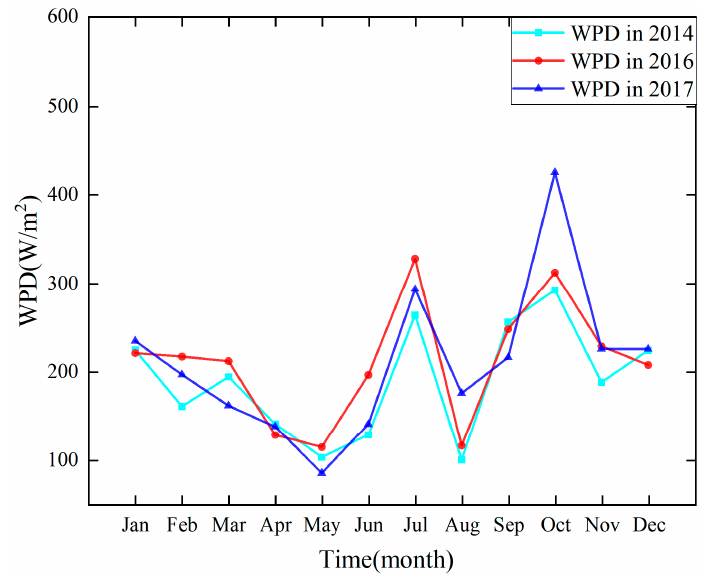
Figure 9. Monthly variation in wind energy density over 3 years.